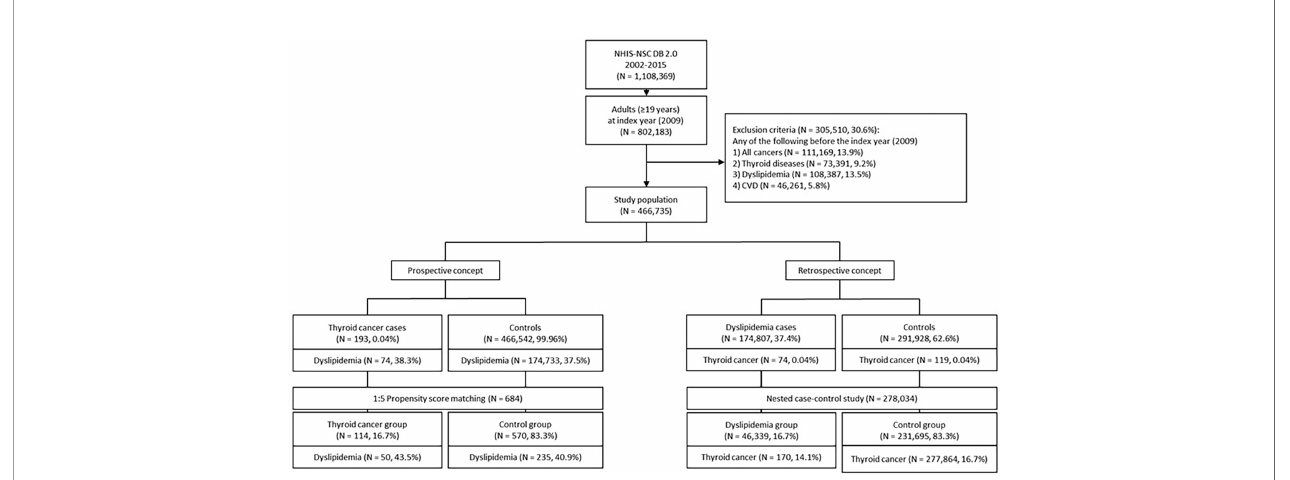
FIGURE 1 | Flowchart illustrating the study design. NHIS-NSC DB, National Health Insurance Service-National Sample Cohort Database; CVD, cardiovascular